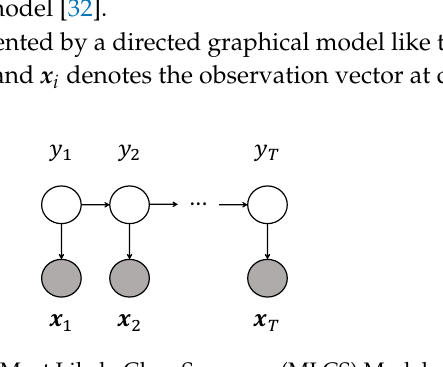
Figure 1. Most Likely Class Sequence (MLCS)